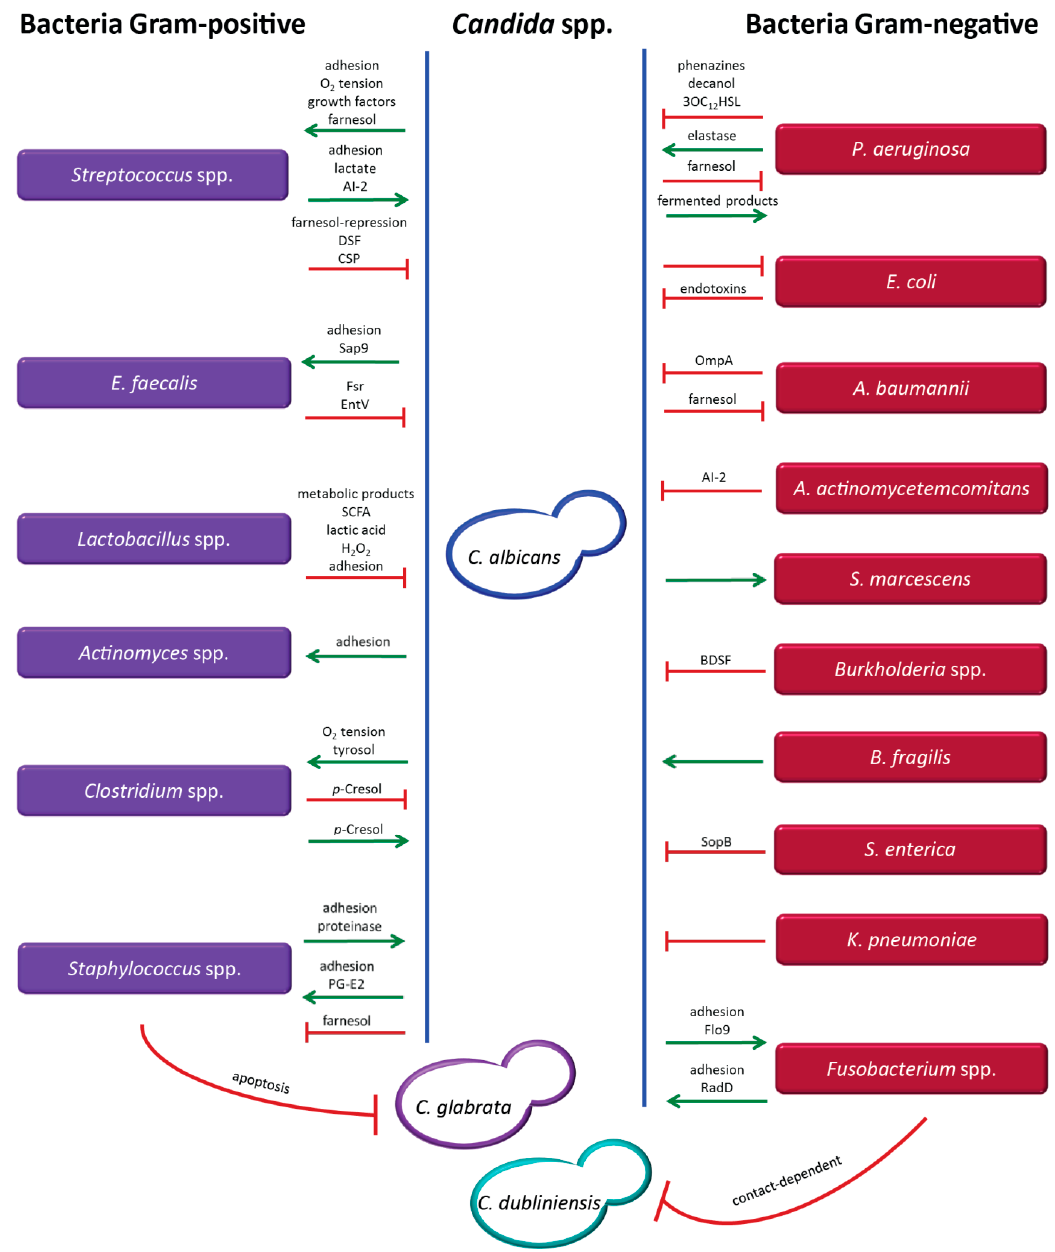
Figure 1. Molecules and factors mediating the interaction between different Candida species and a variety of bacteria. Candida species include Candida (C.) albicans, Candida (C.) glabrata and Candida (C.) dubliniensis . Gram-positive bacteria are represented in lilac ( Enterococcus (E.) faecalis ) and Gram-negative bacteria in red ( Pseudomonas (P.) aeruginosa, Escherichia (E.) coli, Acinetobacter (A.) baumannii, Aggregatibacter (A.) actinomycetemcomitans, Serratia (S.) marcescens, Bacteroides (B.) fragilis, Salmonella (S.) enterica, Klebsiella (K.) pneumoniae ). Green arrows indicate supportive interactions and red lines represent inhibitory effects. If not indicated above the green arrows and red lines, the molecules mediating the interaction are currently unknown.